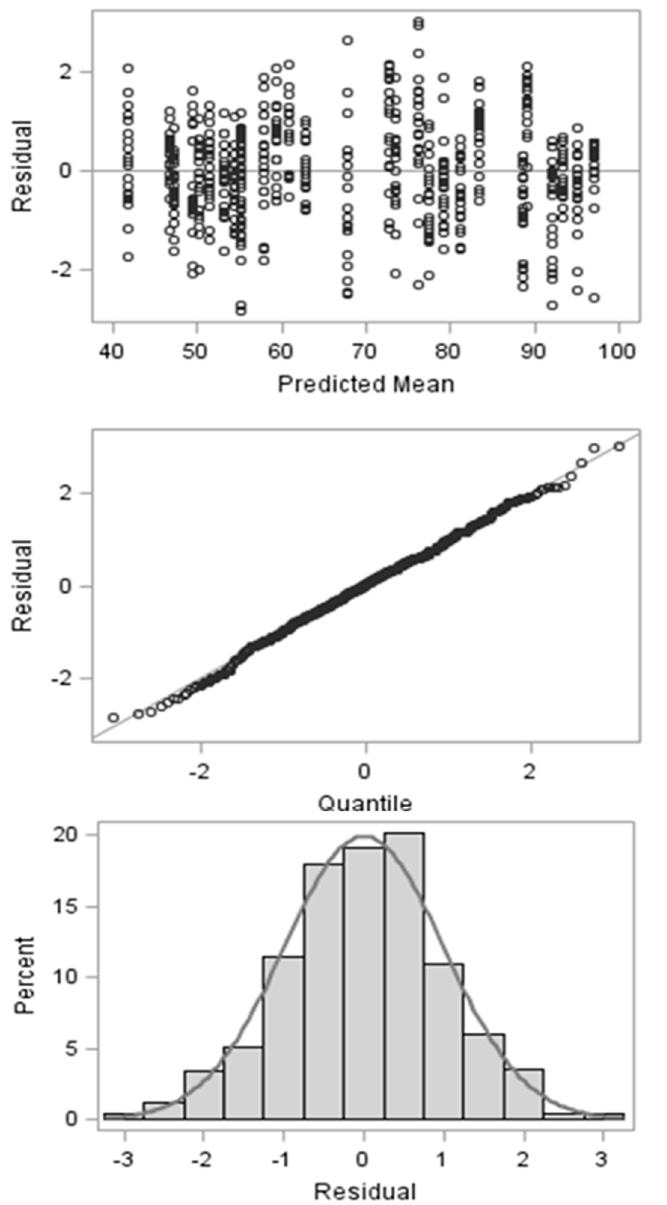
Figure 1. Descriptive pattern of studentized residues for in vitro dry matter digestibility after residual evaluation and outlier elimination.